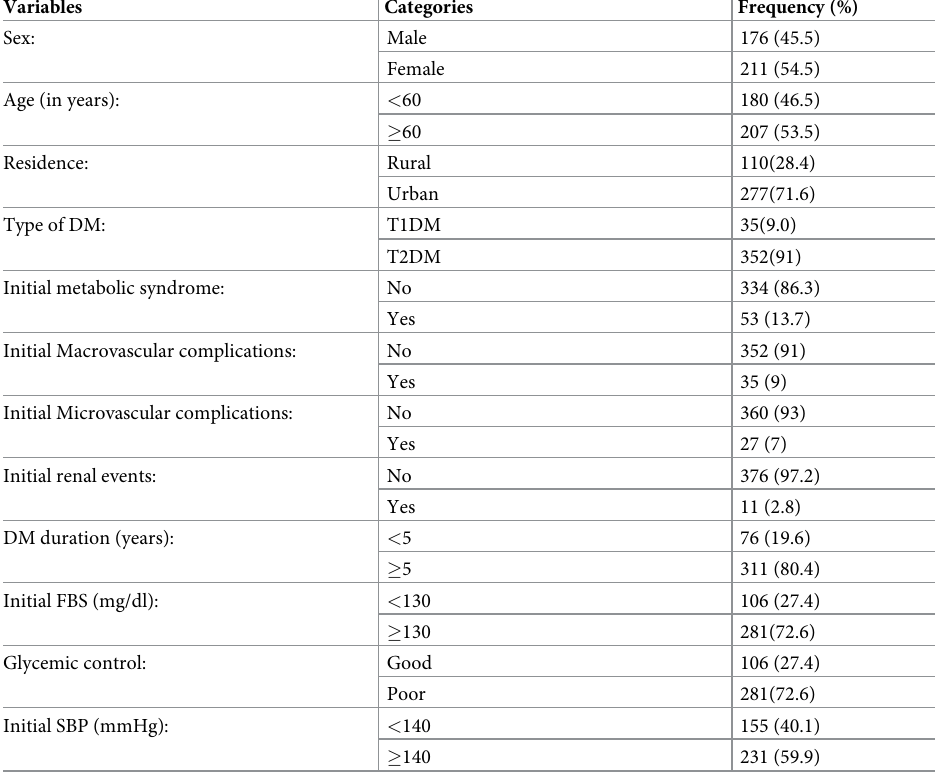
Table 1. Socio-demographic and baseline characteristics of patients with diabetic (N = 387).